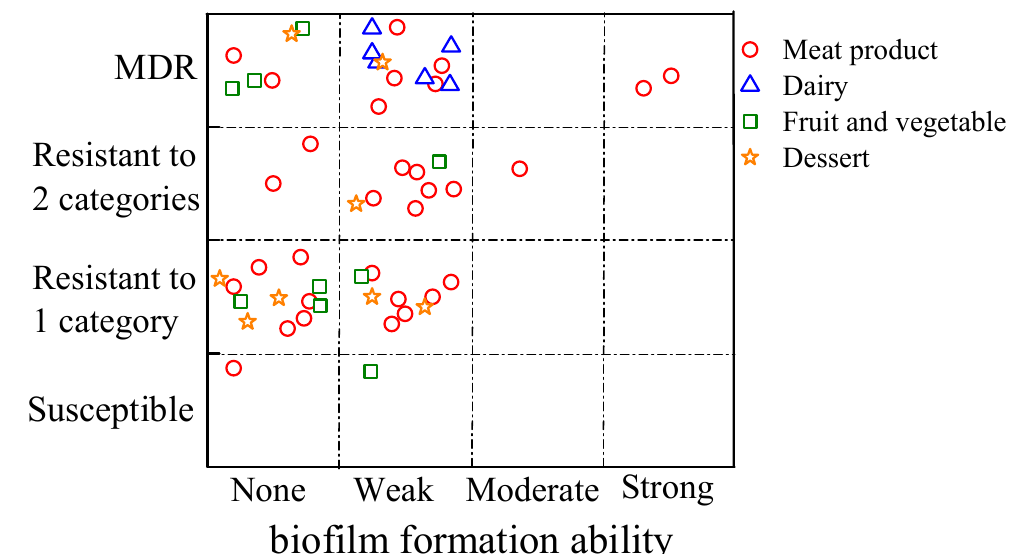
Figure 1. Antibiotic resistance categories and the biofilm formation abilities of the 54 S. aureus isolates Table 5. Phenotypic resistance (P) and the associated genes (G), as well as the biofilm formation from RTEIB foods, including meat products, dairy, fruit and vegetables, and desserts. No biofilm abilities of 54 S. aureus isolates from RTEIB foods, including meat, dairy, fruit and vegetables, and formation ability when OD / cut-o ff OD (ODc) ≤ 1, weak when 1 < OD / ODc ≤ 2, moderate when 2 < desserts. OD / ODc ≤ 4, strong when 4 < OD / ODc.